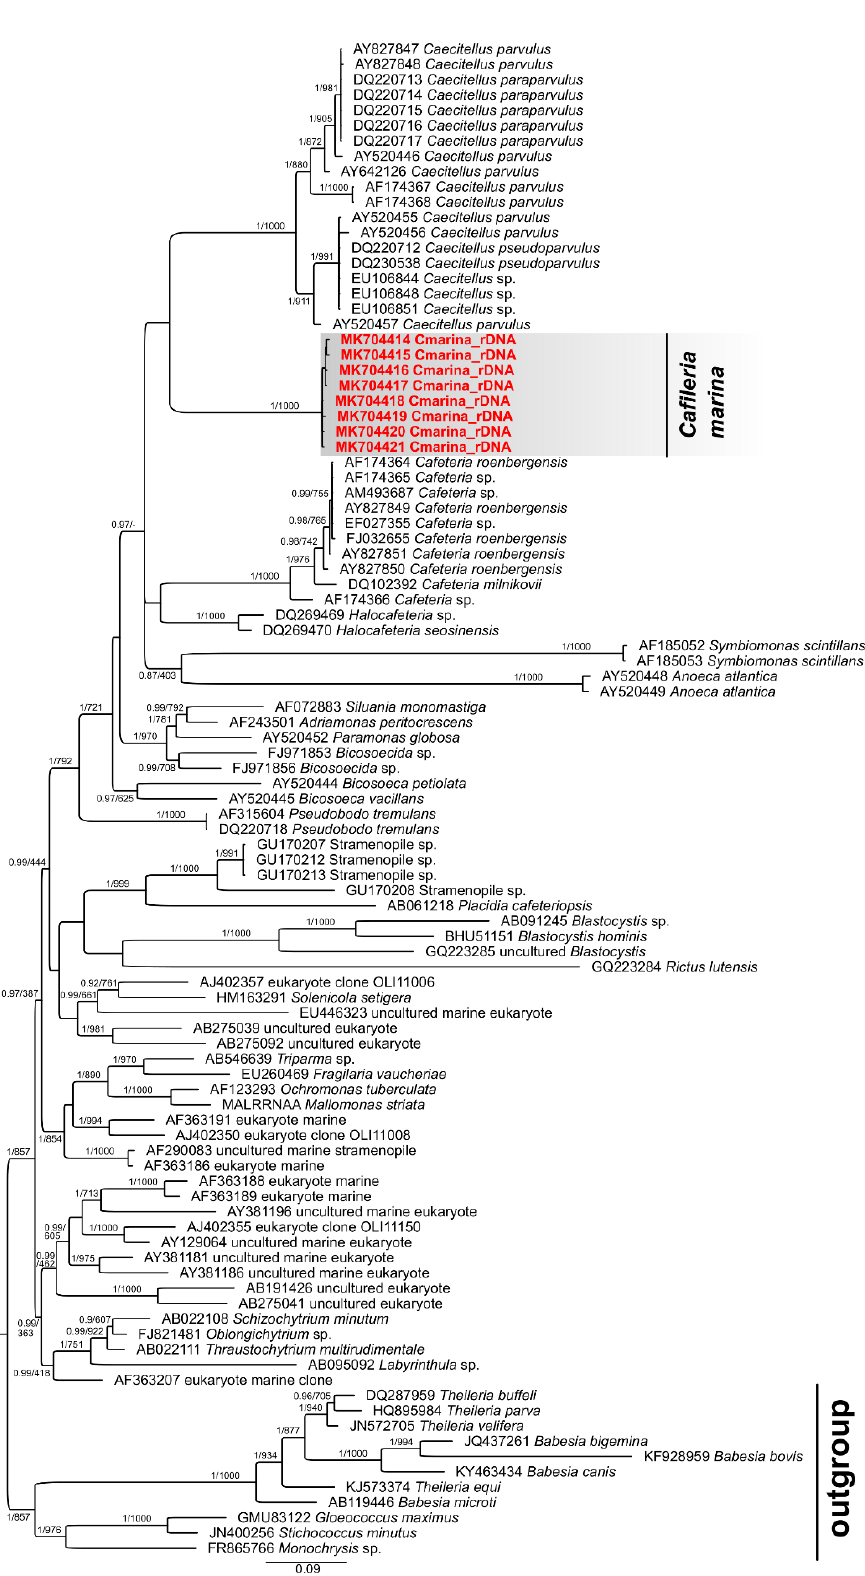
Figure 5. Phylogenetic tree based on 18S sequences of bicosoecids and closely related representatives of Stramenopiles with the final length of alignment of 1609 bp. The presented tree was computed by the software MrBayes. Sequences of apicomplexans were used as an outgroup to root the final tree. Statistical support for each branch was obtained from the Bayesian posterior probability and maximum-likelihood bootstrap. Posterior probabilities lower than 0.86 are not shown in the figure.